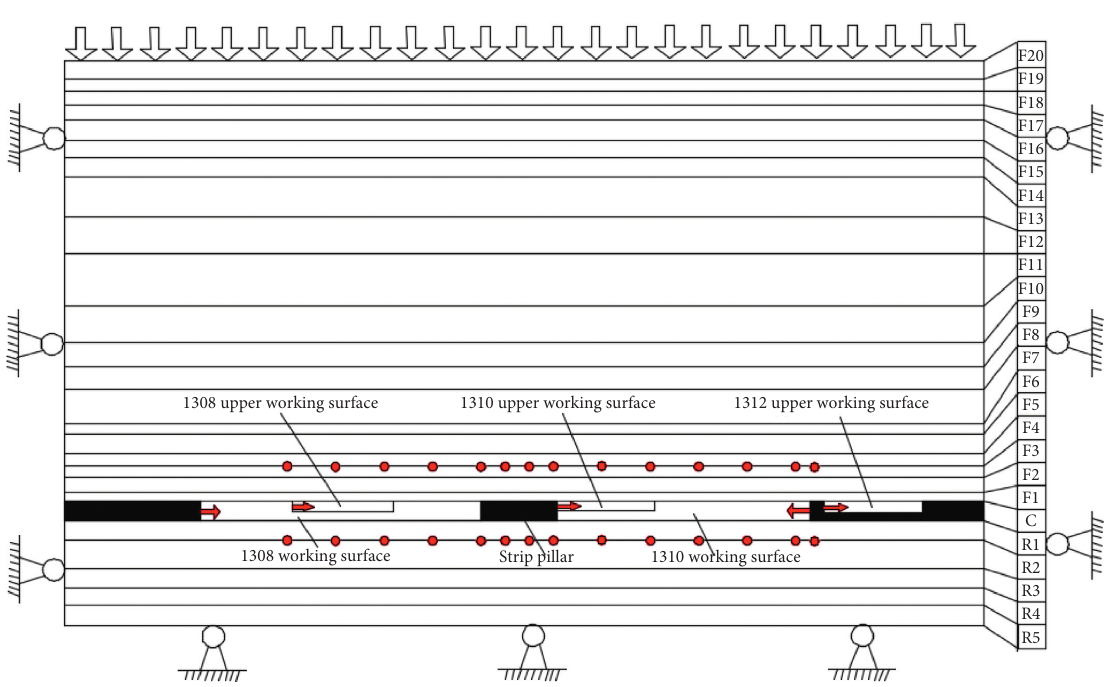
Figure 9: Model excavation and monitoring point